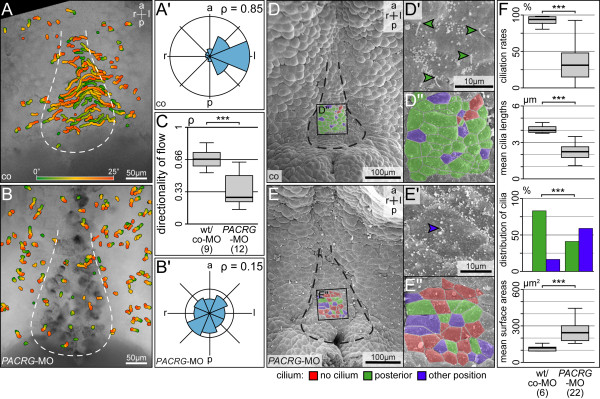
Absence of leftward flow and altered gastrocoel roof plate (GRP) morphology in PACRG morphants. (A,B) Loss of leftward flow in PACRG morphant GRPs. Gradient time trail (GTT) projection of directed bead trajectories (25 s, indicated in color bar). (A’,B’) Circular histograms of mean angles of trajectories. (C) Quality of flow, as depicted by the dimensionless number rho. (D,E) SEM analysis of wild-type (D) and PACRG morphant (E) dorsal explants. GRP area indicated by dashed line. Note the loss of posterior polarization of cilia in enlargements of characteristic cells in (D’,E’), and the marked increase in non-ciliated cells (D”,E”). (F) Altered ciliation rates, mean cilia lengths, polarization of residual cilia and mean apical cell surface areas, as assessed in standardized central GRP areas of 86 μm2 each [21].